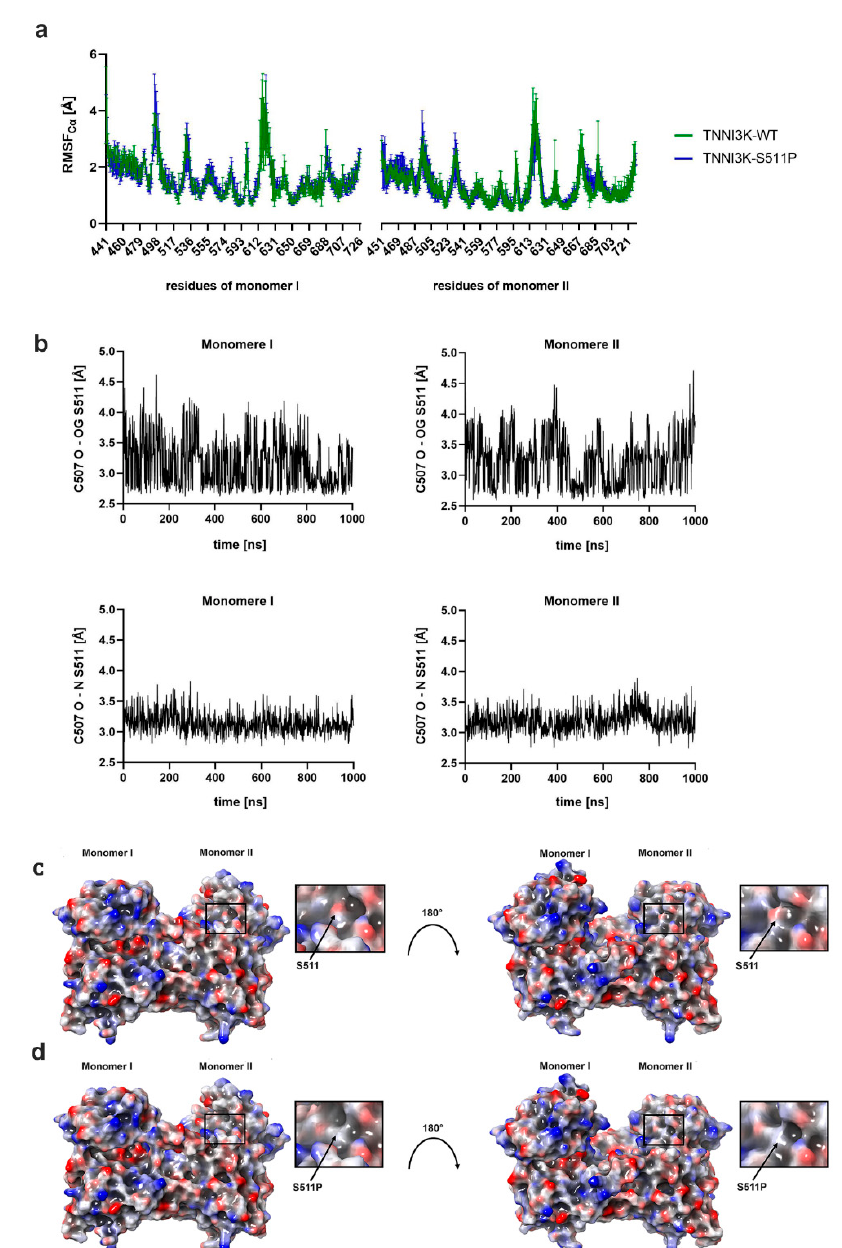
Figure 2. Root mean square fluctuation, hydrogen bond analysis, and electrostatic surface potential map. ( a ) Comparison of root mean square fluctuation values of TNNI3K-WT (green) and TNNI3K- S511P (blue) during three independent 1 µs MD simulations with error bars. Alignments and measurements were performed for the C α carbon atoms. ( b ) Hydrogen bond analysis. Length of the hydrogen bonds between Cys507 and Ser511 in TNNI3K-WT as a mean value of three independent MD simulations (1 µs). ( c,d ) A comparison of the electrostatic surface potential of TNNI3K-WT ( c ) and TNNI3K-S511P ( d ), demonstrating that p.Ser511Pro leads to a more hydrophobic protein surface (“red white blue” color ramp with a minimum of − 0.3 and a maximum of 0.3).